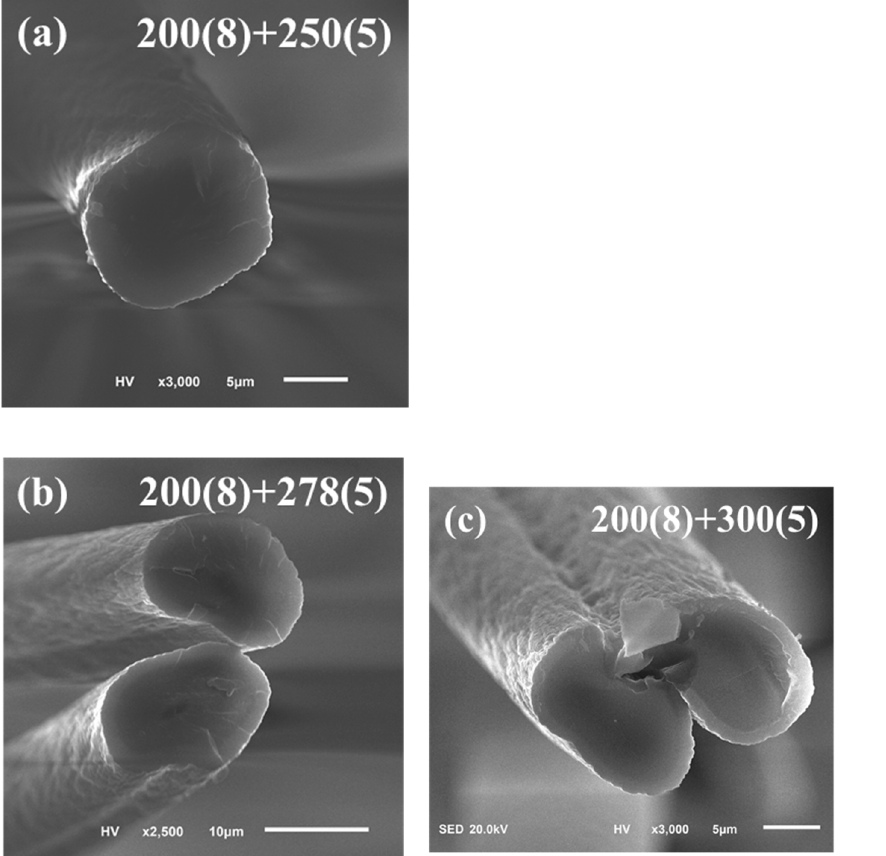
Figure 6. The cross-section view of the pre-oxidized specimens ( a ) 200(8) + 250(5) ( b ) 200(8) + 278(5) and ( c ) 200(8) + 300(5) using SEM.